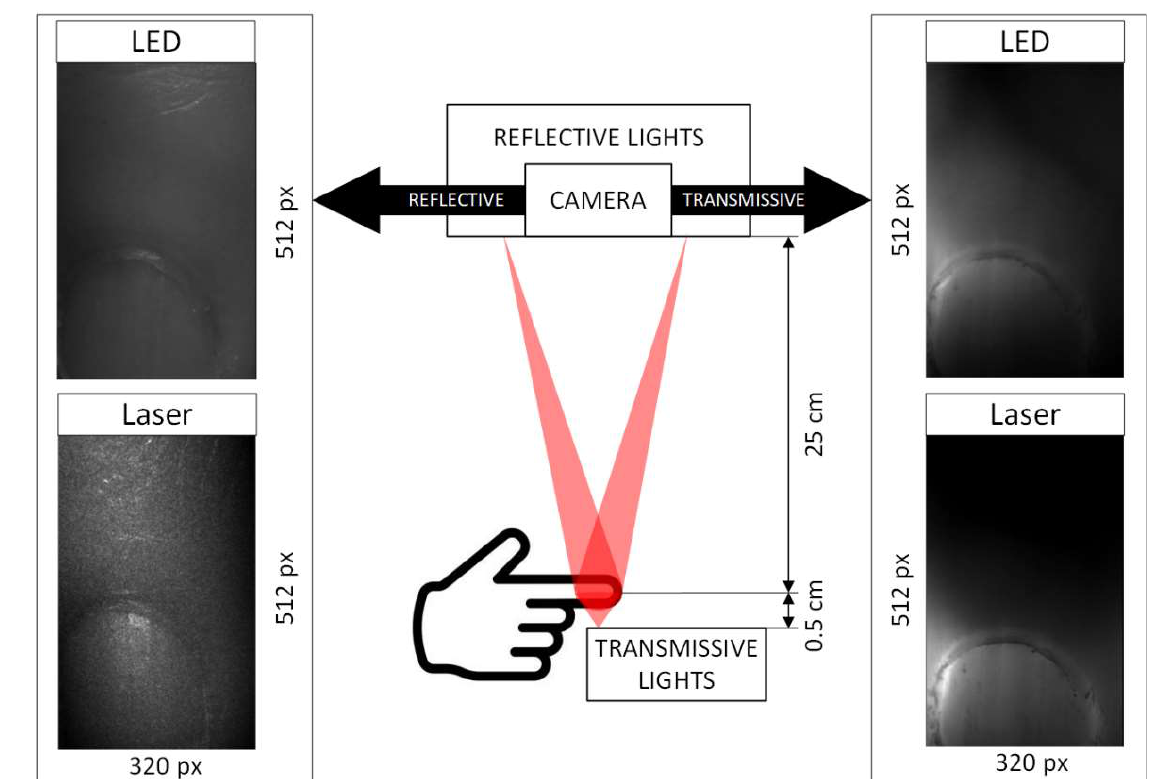
Figure 2. Setup diagram with sample 639 nm raw images in reflective ( left ) and transmissive mode ( right ). Left top: reflective image with LED illumination. Left bottom: reflective image with laser illumination (clear speckle pattern visible). Right top: transmissive image with LED illumination. Right bottom: transmissive image with laser illumination.